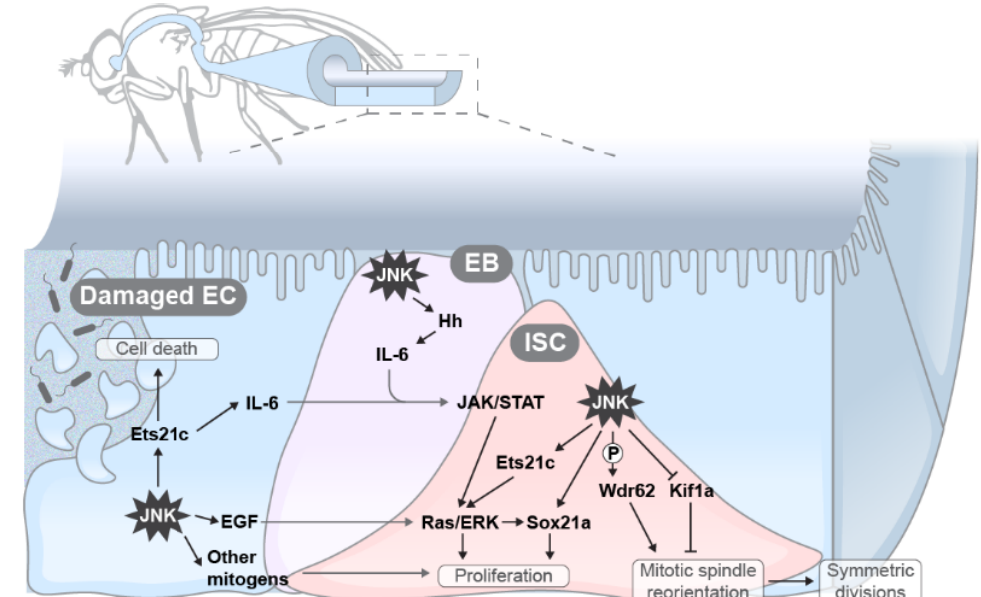
Figure 3. The JNK pathway during homeostasis of the Drosophila gut. Damage or bacterial infection in the Drosophila mid- gut causes JNK activation in enterocytes (ECs). JNK induces expression of Ets21c, which then induces the secretion of inflammatory cues and mitogens such as IL-6 and EGFs. In cases of severe or chronic damage, JNK/Ets21c activity also induces apoptosis of the EC. Enteroblasts (EBs) activate JNK upon stress. This leads to the production of Hh, which acts in an autocrine manner to induce IL-6 production in EBs. In intestinal stem cells (ISCs), IL-6 and EGFs are received and integrated by the JAK/STAT and Ras/ERK pathways, respectively, to induce stem cell proliferation. Autonomous JNK pathway activation in ISCs upregulates its effectors Ets21c and Sox21a, which promote proliferation. In addition, JNK signaling induces symmetric divisions in ISCs by reorientating the mitotic spindle through its effector Wdr62 and by transcriptionally inhibiting Kif1a.